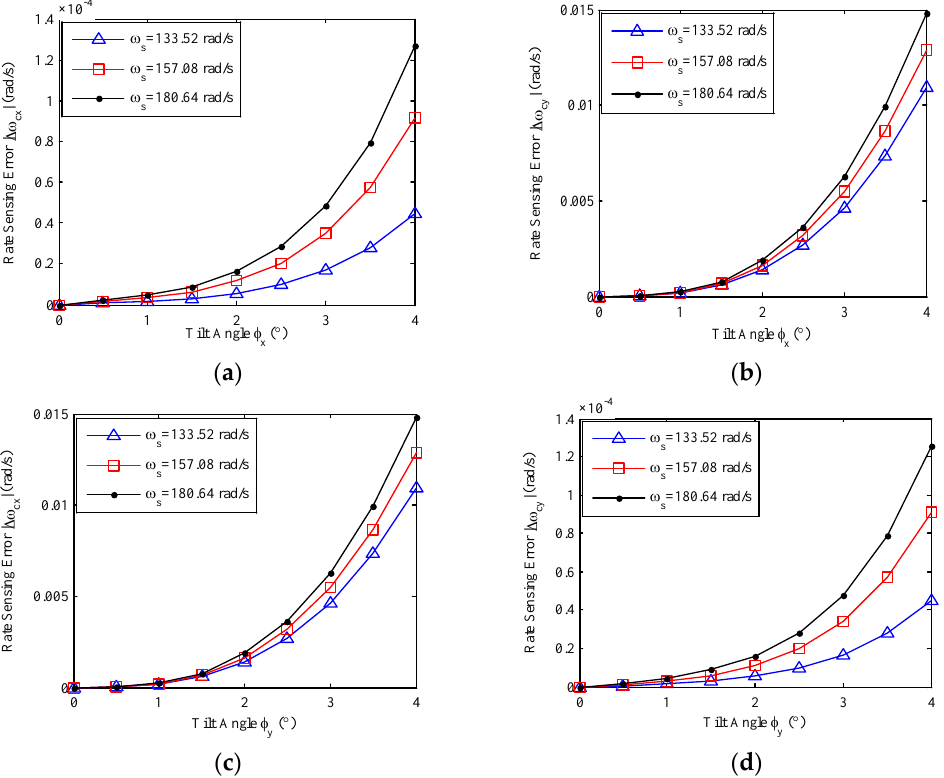
Figure 3. Relationship between rate sensing errors and tilt angles: ( a ) X -axis rate sensing error versus x -axis tilt; ( b ) Y -axis rate sensing error versus y -axis tilt; ( c ) X -axis rate sensing error versus y -axis tilt; ( d ) Y -axis rate sensing error versus x -axis tilt.